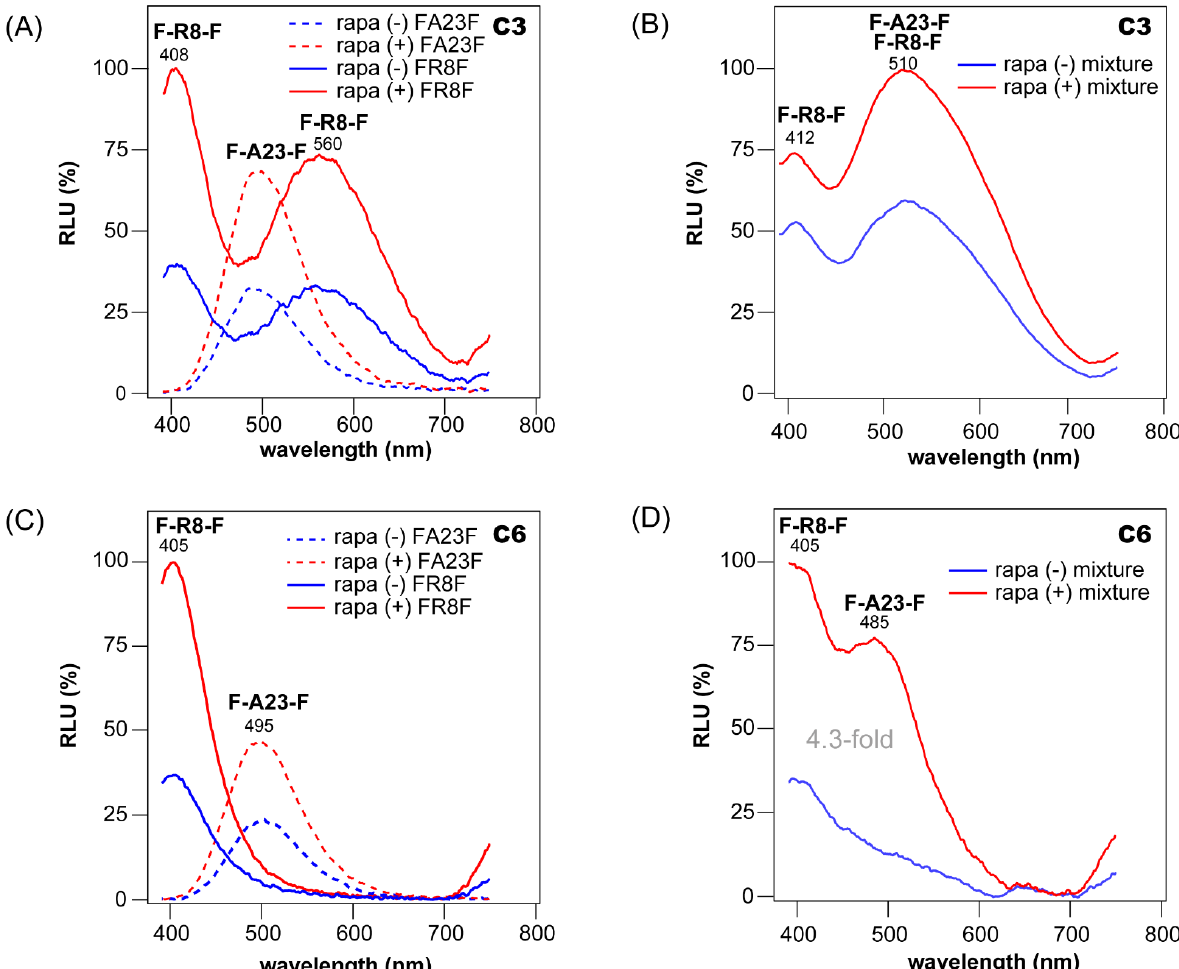
Figure 5. ( A ) Respective BL spectra of F-A23-F (dotted line) and F-R8-F (solid line) in the presence (+) or absence (-) of rapamycin (rapa). The BL spectra were developed with C3 . The inset shows the working mechanism of the molecular strain probe F-R8-F. ( B ) The signatural spectra of the mixture of F-A23-F and F-R8-F in the presence or absence of rapamycin. ( C ) Respective BL spectra of F-A23-F (dotted line) and F-R8-F (solid line) in the presence (+) or absence (-) of rapamycin (rapa), which were illuminated by C6 . The inset shows the working mechanism of the molecular strain probe F-A23-F. ( D ) The signatural spectra of the mixture of F-A23-F and F-R8-F in the presence or absence of